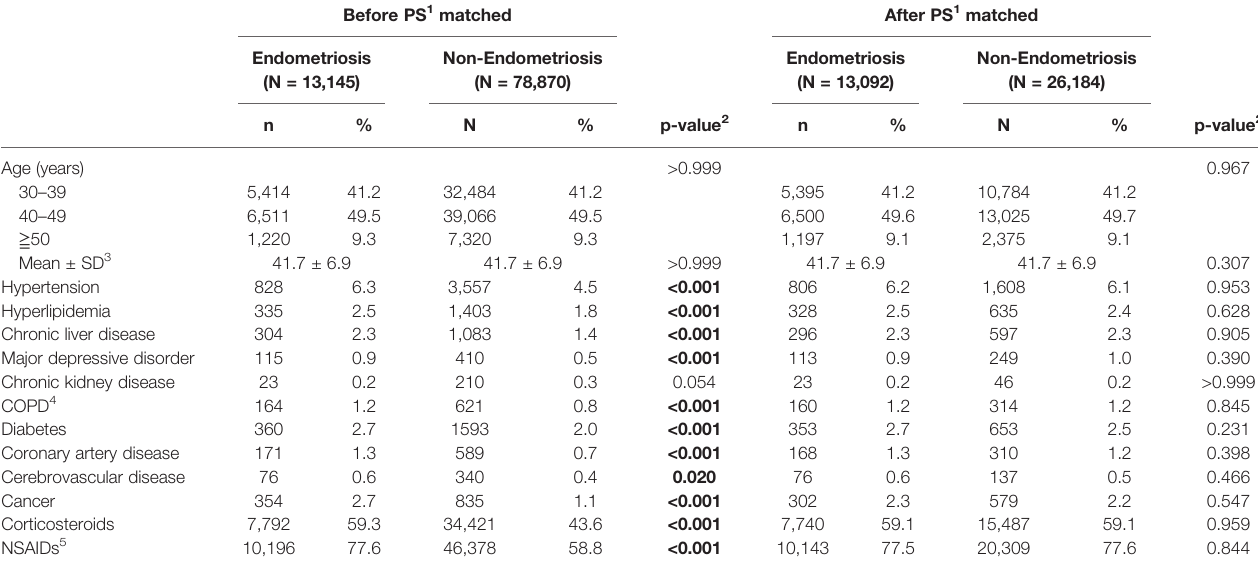
TABLE 1 | Demographic characteristics of enrolled endometriosis and non-endometriosis subjects. Before PS 1 matched After PS 1 matched